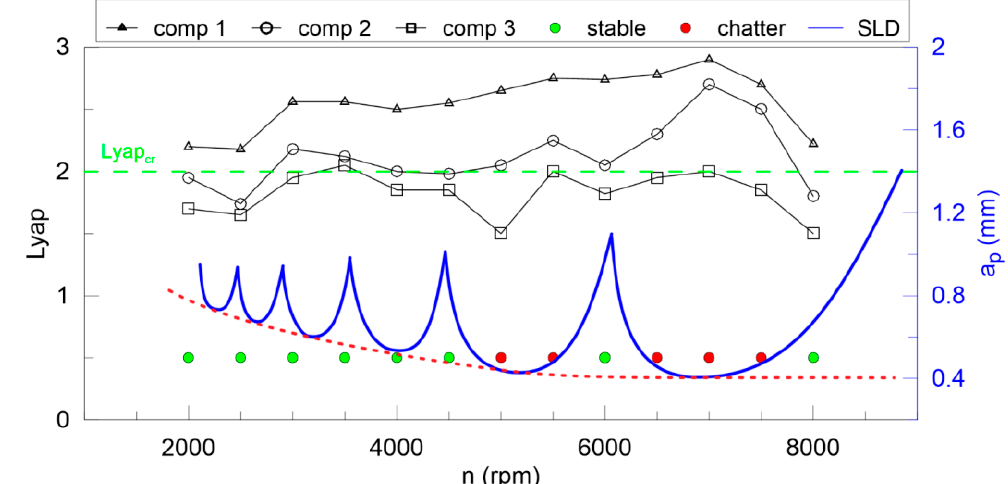
Figure 12. The largest Lyapunov exponent (left axis) and the hypothetical stability lobe diagram (right axis) versus rotational speed.